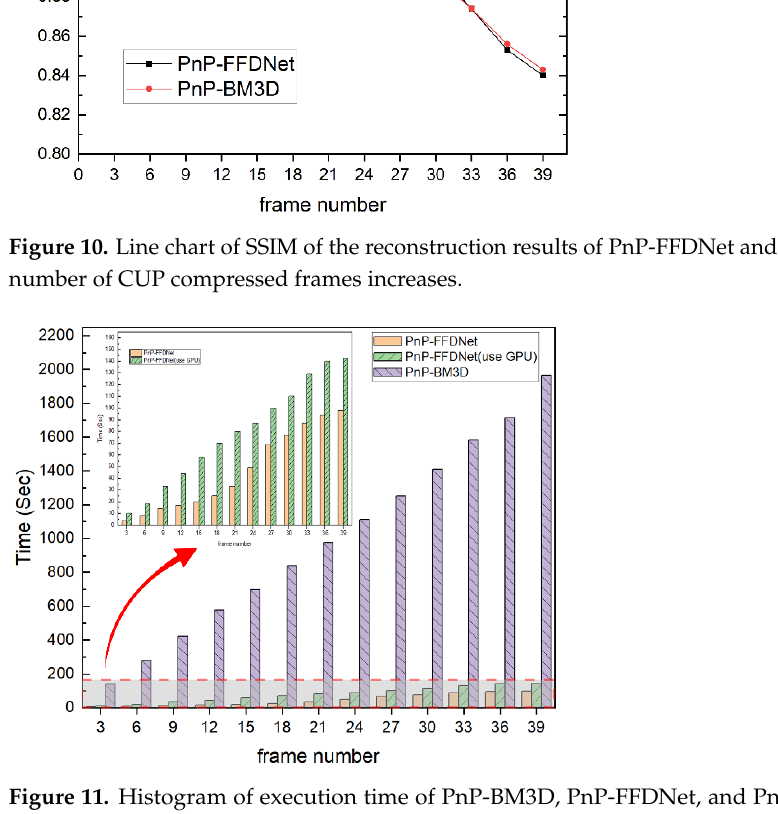
Figure 11. Histogram of execution time of PnP-BM3D, PnP-FFDNet, and PnP-FFDNet (use GPU) when the number of compressed frame increases. The subplot in Figure 7 is an enlarged histogram of the red dashed area.